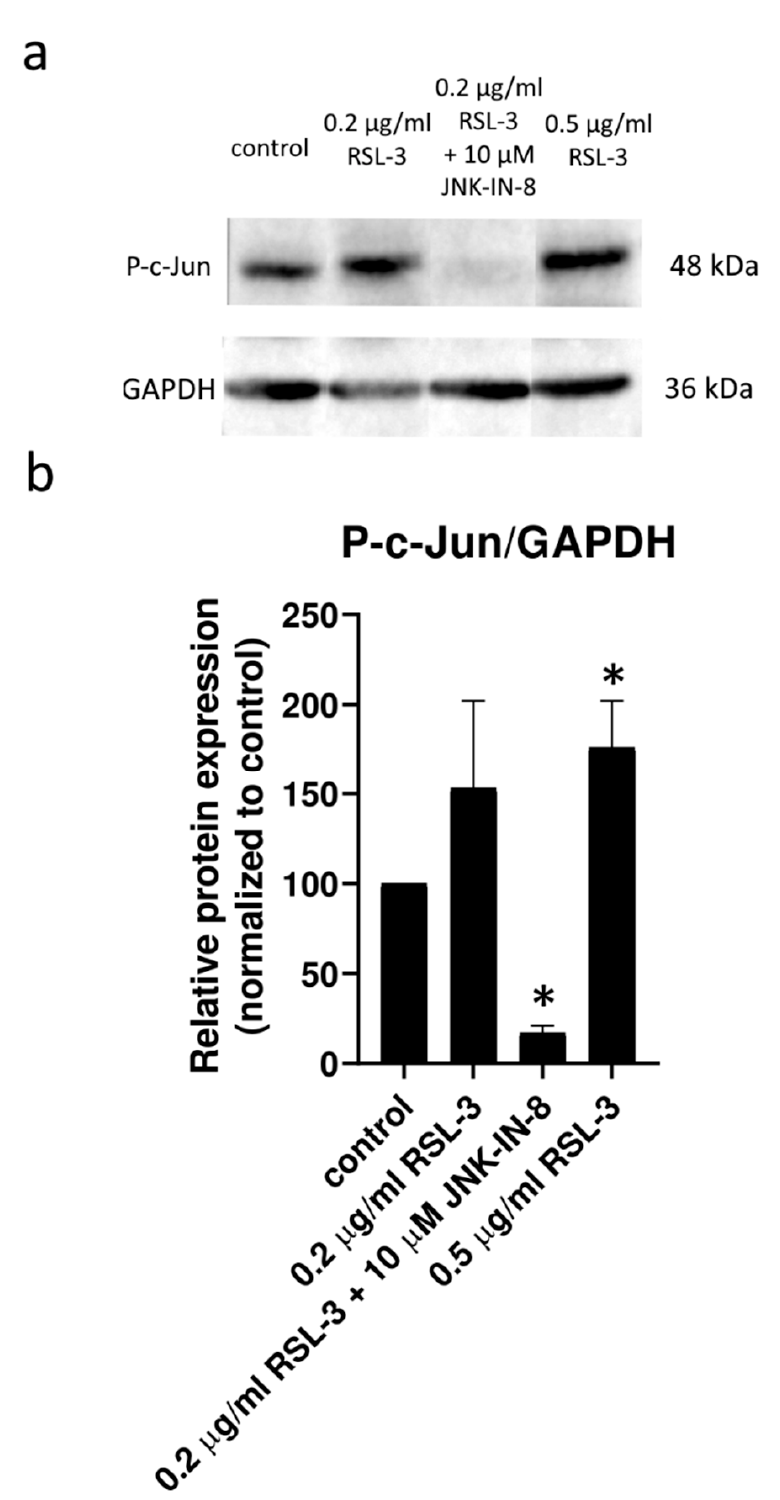
Figure 3. Western blot analysis of total protein samples for c-Jun phosphorylation in HT-1080 cells in response to RSL-3 treatment. ( a ) Western blot analysis was performed as described below. Phosphorylated c-Jun protein levels were determined after 24 h treatment with RSL-3 (0.2 µ g/mL or 0.5 µ g/mL) in the presence or absence of the JNK inhibitor, JNK-IN-8 (10 µ M). GAPDH were labeled for loading the control. ( b ) Densitometry data represent the intensity of phosphorylated c-Jun normalized to GAPDH; each data point represents the average ± SD from at least three independent experiments. * Significantly different ( p < 0.05) from